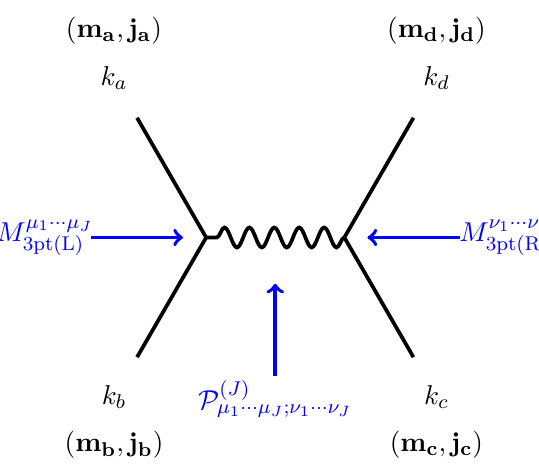
Figure 1 . Schematic Feynman diagram for a massive spinning particle